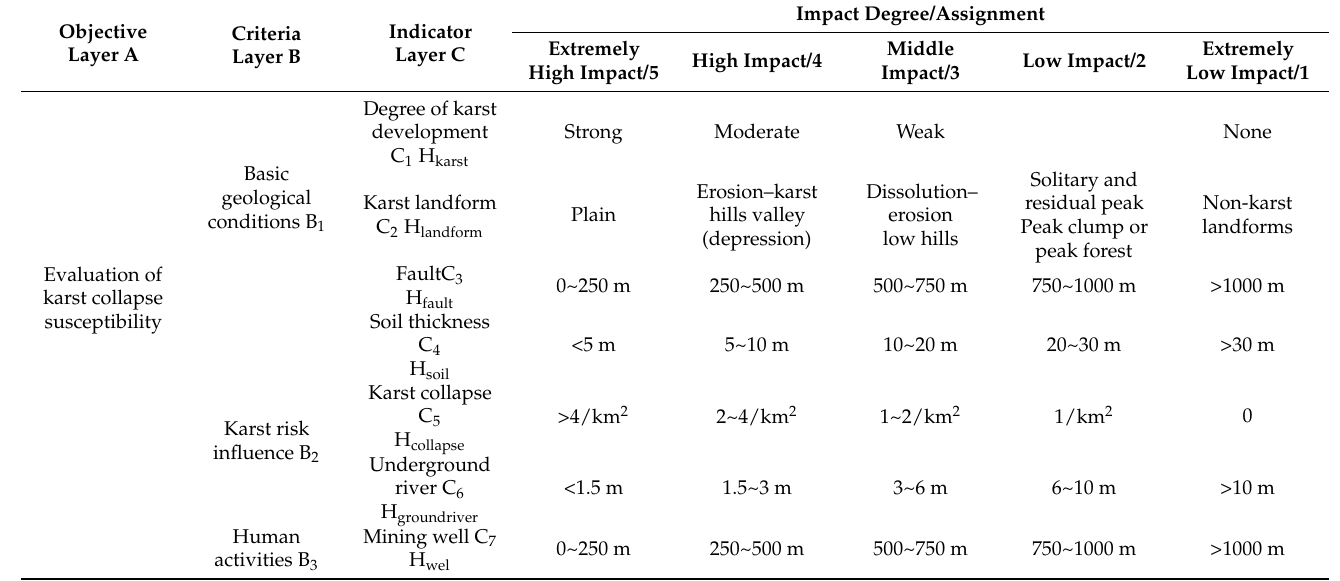
Table 3. Evaluation factors and assignment table of structural karst collapse susceptibility